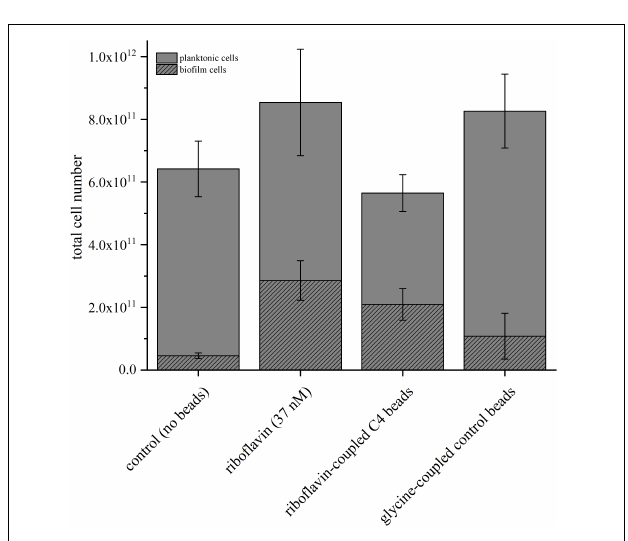
FIGURE 4 | Comparison of the total cell number determined via qPCR in BES with the addition of riboflavin, glycine-coupled control beads and riboflavin-coupled beads with a linker length of 4 carbon atoms. The riboflavin-coupled beads were added so that the overall riboflavin concentration was equal to the experiment with free riboflavin (37 nM). The control experiment was conducted without addition of riboflavin or magnetic beads. Gray bars indicate planktonic cells; striped bars biofilm cells. Error bars represent the standard deviations from means of samples taken in independent